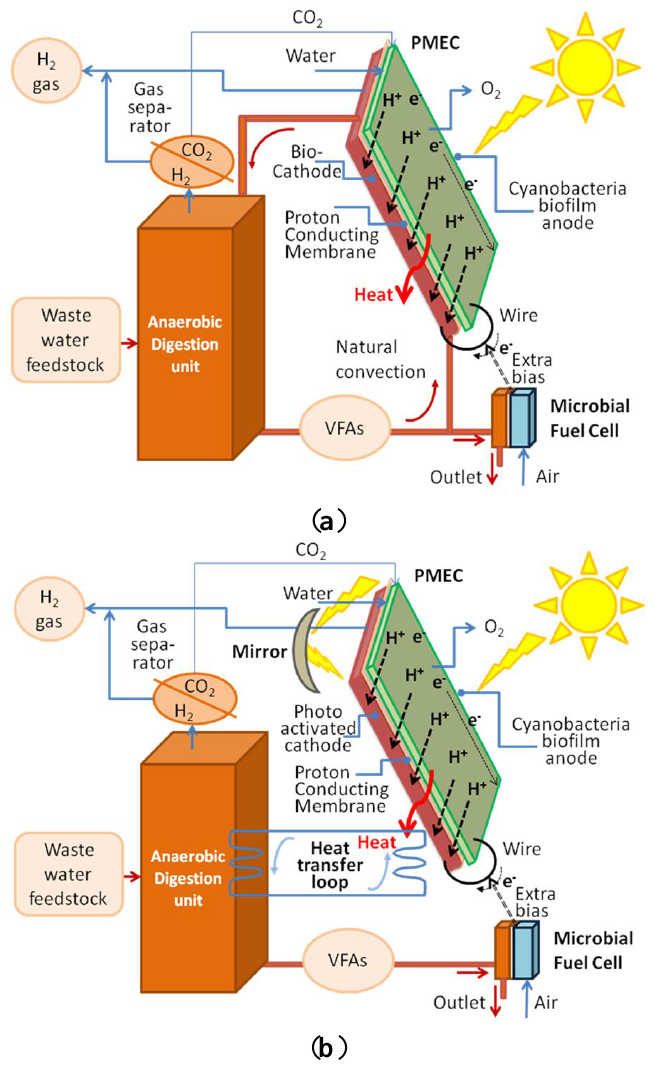
Figure 3. ( a ) Integration of the PMEC reactor with a DF unit applying an extra bias provided by a MFC operating on the outlet flow ( b ) integrated, if needed, by photochemical conversion at the anode induced by reflected